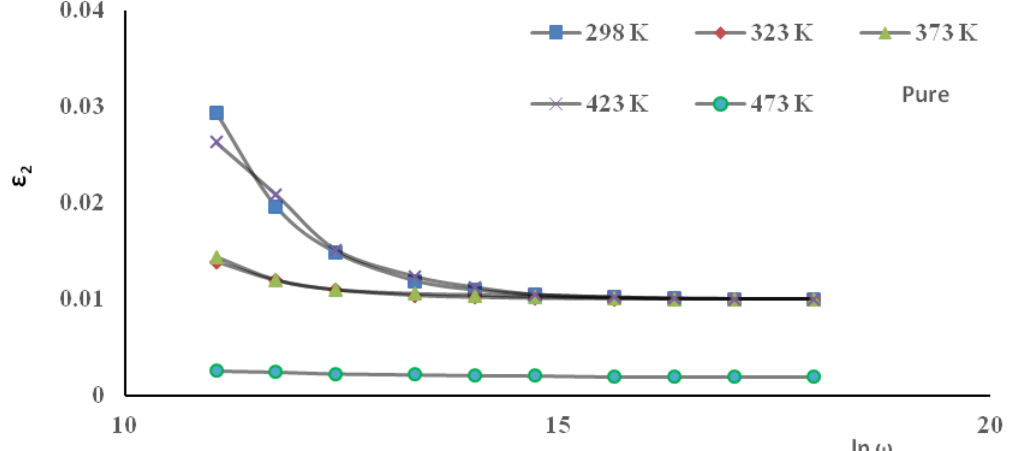
Fig. 6: The variation of (ε ) with ln(ω) for pure ZnS films treated at different temperatures. 2